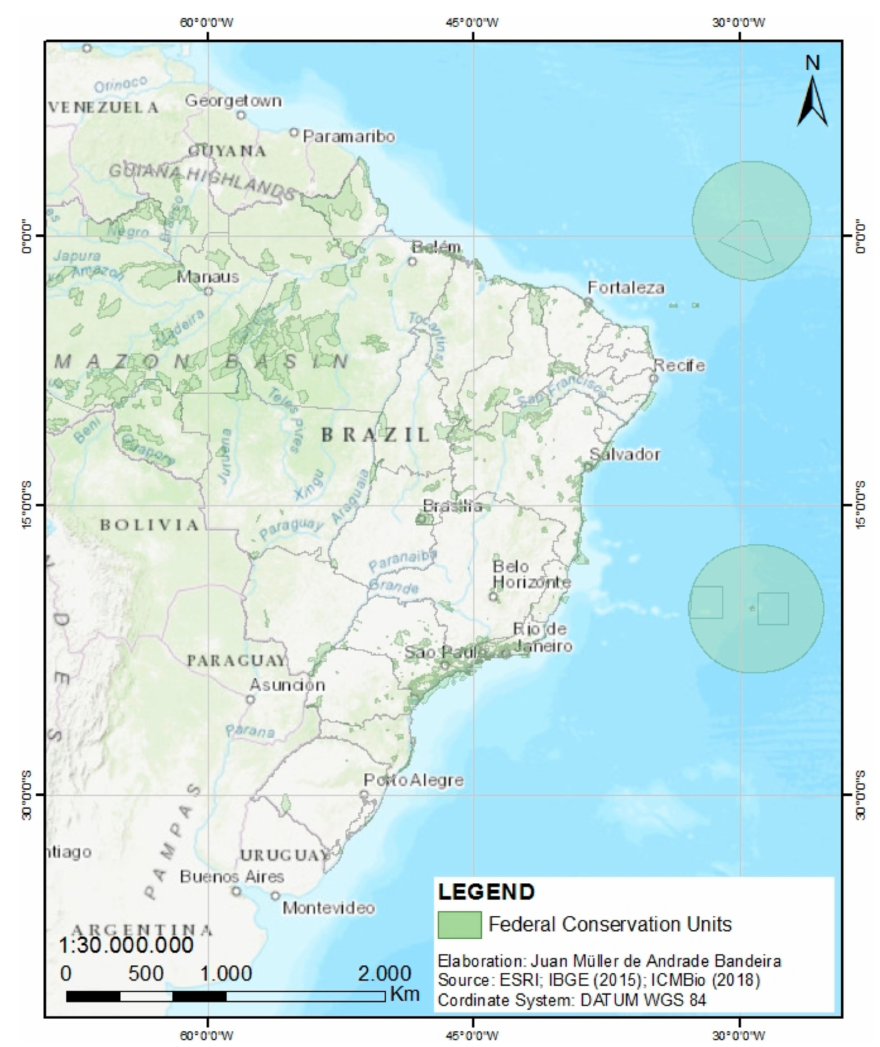
Figure 6. Environmental conservation units. Source: ICMBio [26], state agencies and Instituto Socioambiental